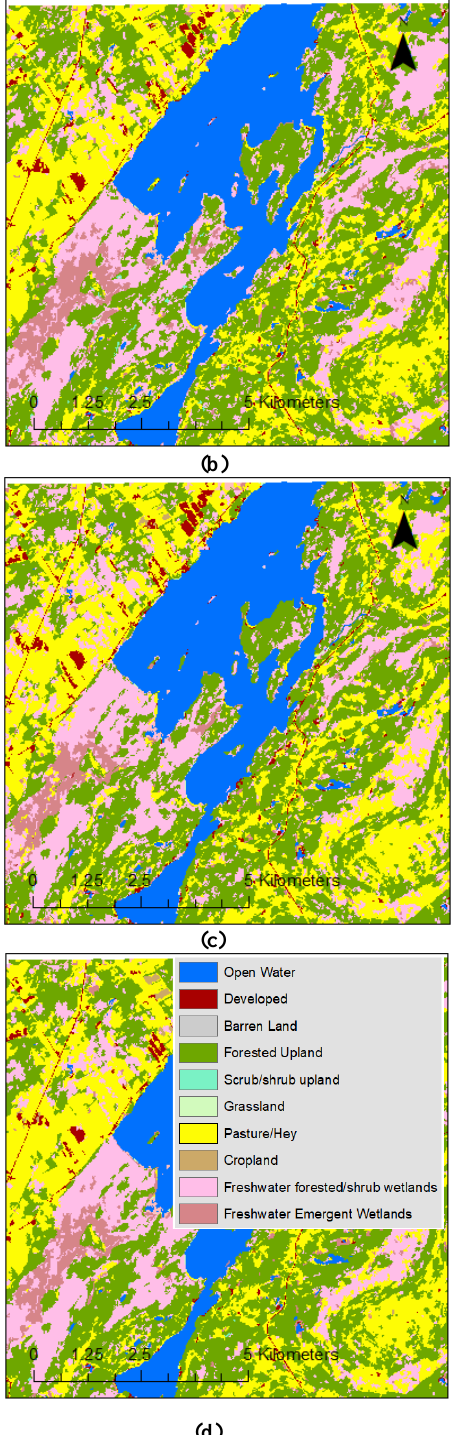
Figure 3. (a-d) The classification results in the four different scenarios. a) Mono-season and no GLCM feature is included. b) Multi-season and no GLCM features are included. c) Mono-season and seven GLCM feature is included. d) Multi-season and seven GLCM features are